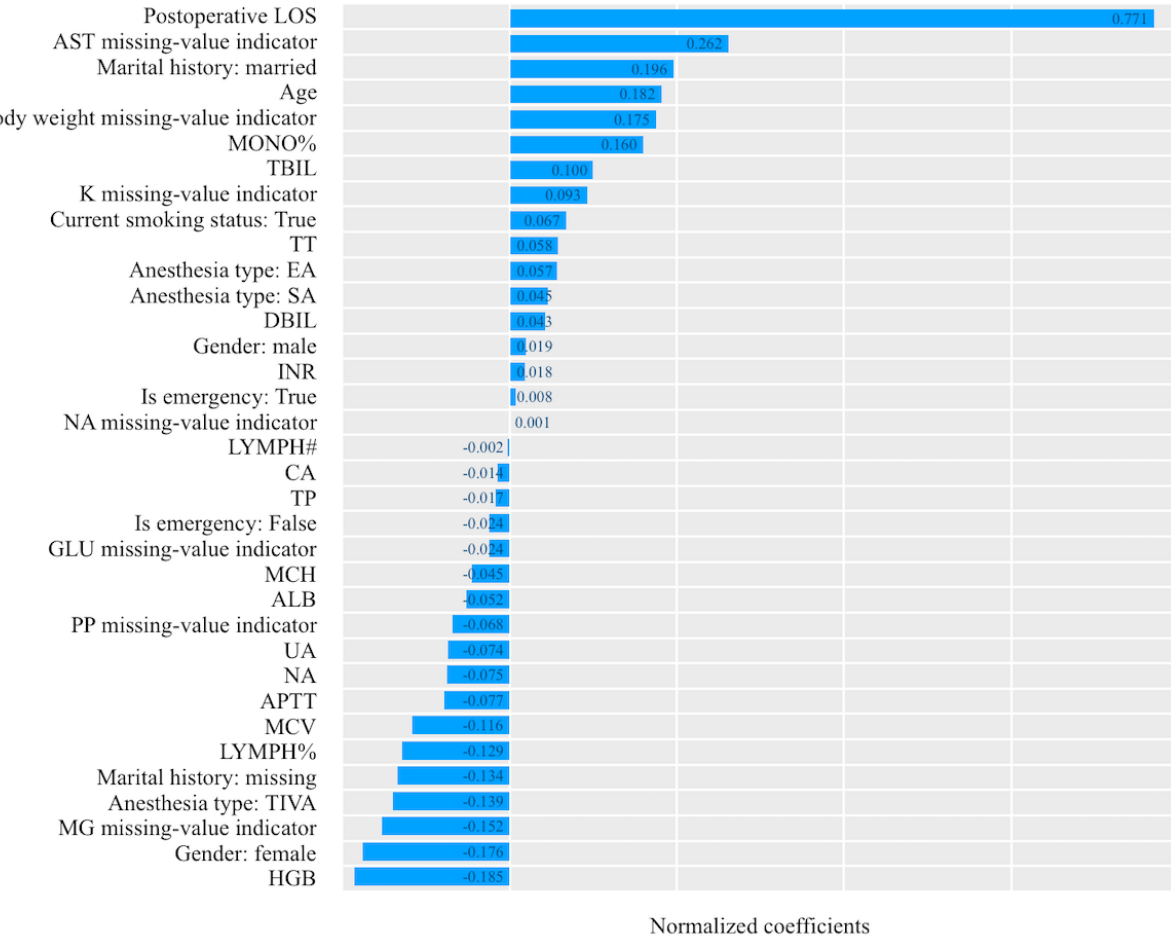
Figure 4. The normalized coefficients of the features in the LASSO (least absolute shrinkage and selection operator) model without text